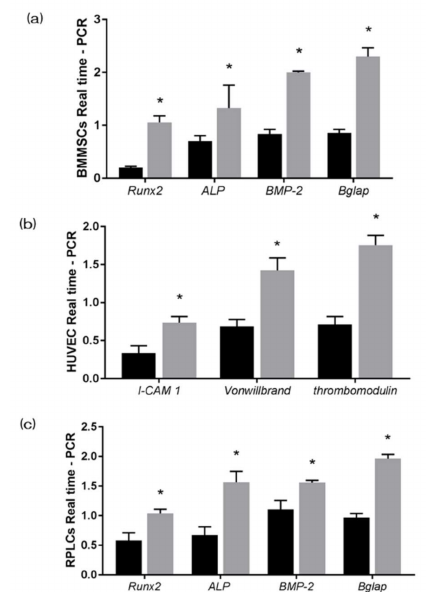
Figure 6. The gene expression related to the induction of hard tissue di ff erentiation and the gene expression related to angiogenesis on the NANOZR surface of the test and the control group were analyzed. In this experiment, the assay was performed at a measurement time specific to each gene. Significantly higher gene expression was observed on the material surface of the test group at all measurement times. (Gray bar—untreated surface, black bar—UV-treated surface). (*: p < 0.05)